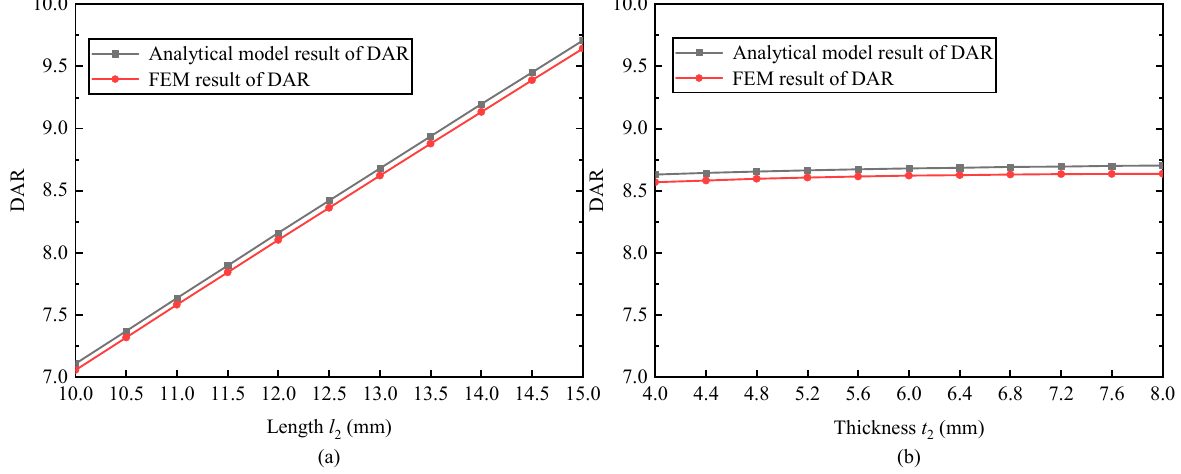
Figure 7. The changes in DAR with the connecting body varied. ( a ) The connecting body length l 2 . ( b ) The connecting body thickness t 2